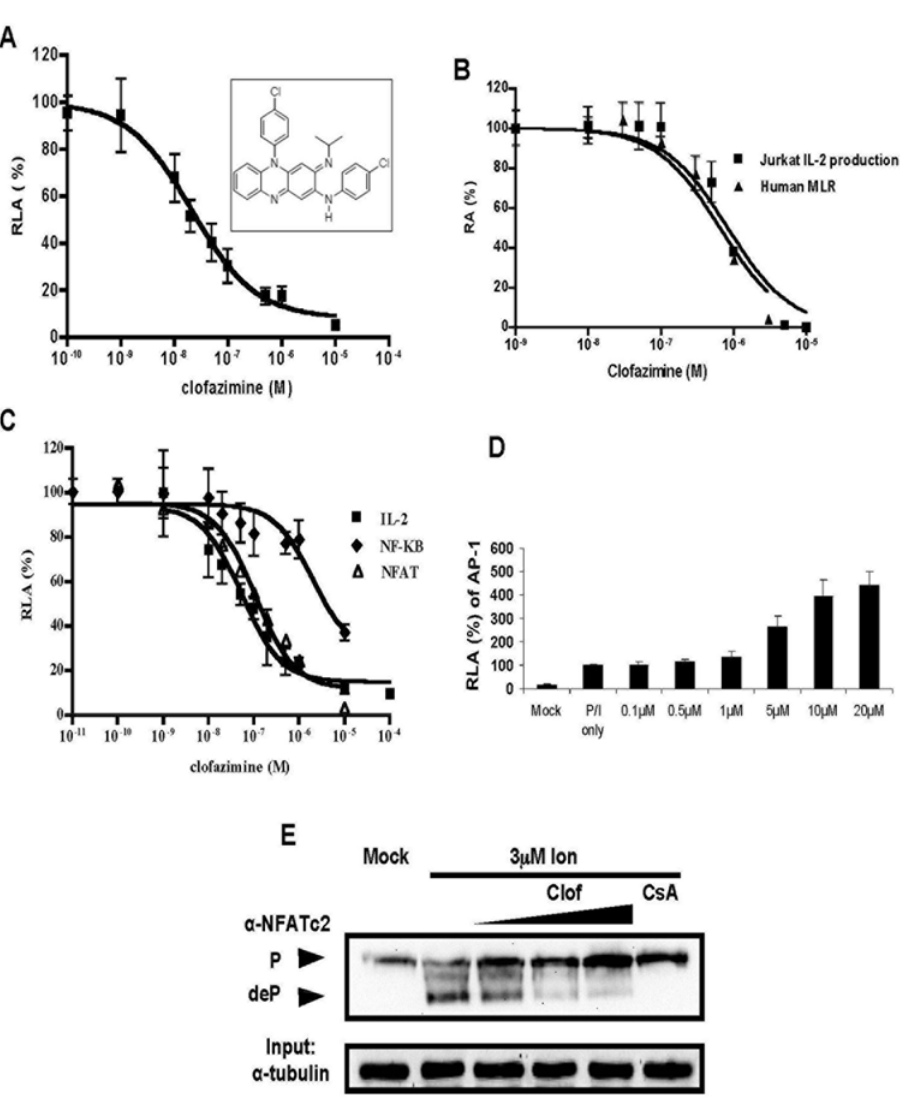
Figure 1. Clofazimine inhibits IL-2 production and NFAT activation in Jurkat T cells. ( A ) Clofazimine (structure shown in inset) inhibits IL-2 proximal promoter driven-luciferase stimulated by PMA/ionomycin in Jurkat T cells (n=6). The IC 50 s for reporter assay is 21.8 6 4.4 nM. ( B ) Clofazimine inhibits IL-2 production in PMA/thapsigargin-stimulated Jurkat T cells (IC 50 =1.10 6 0.26 m M) and human mixed lymphocyte reaction (MLR) (IC 50 =0.90 6 0.17 m M) (n=6 each). ( C ) Clofazimine inhibits NFAT pathway in Jurkat T cells. The IC 50 s of clofazimine in the IL-2, NFAT, NF- k B luciferase reporter assays are 56.0 6 14.8 nM, 113 6 30 nM and 2.43 6 1.25 m M, respectively (n=6 each). Both reporters were stimulated with PMA/ionomycin. ( D ) Clofazimine significantly enhances AP-1 luciferase reporter at high concentrations ( . 1 m M, n=6). The reporter was also activated by PMA/ionomycin. ( E ) Clofazimine inhibits dephosphorylation of endogenous NFATc2 in response to ionomycin treatment. NFATc2 and a -tubulin were detected by Western blot using specific antibodies. doi:10.1371/journal.pone.0004009.g001 (Fig. 2A–B), over 80% of cells exhibited elongation of the oscillation period upon treatment with clofazimine, indicating that this effect is statistically significant (Fig. 2D).